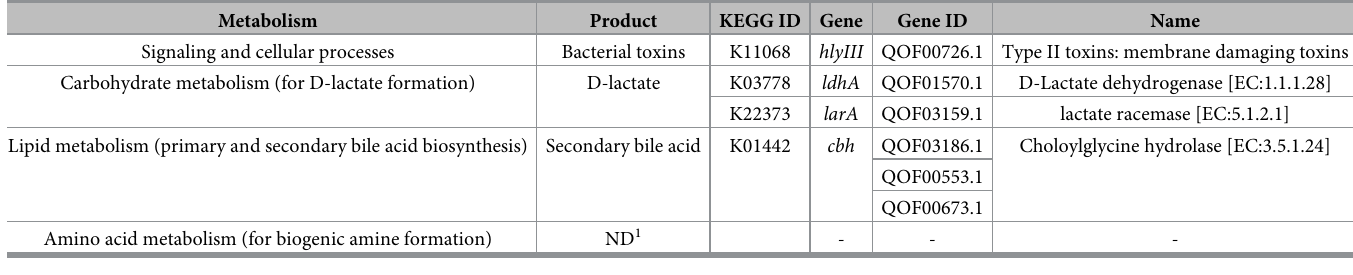
Table 2. List of virulence and undesirable genes detected in the genome of Lactiplantibacillus plantarum PMO